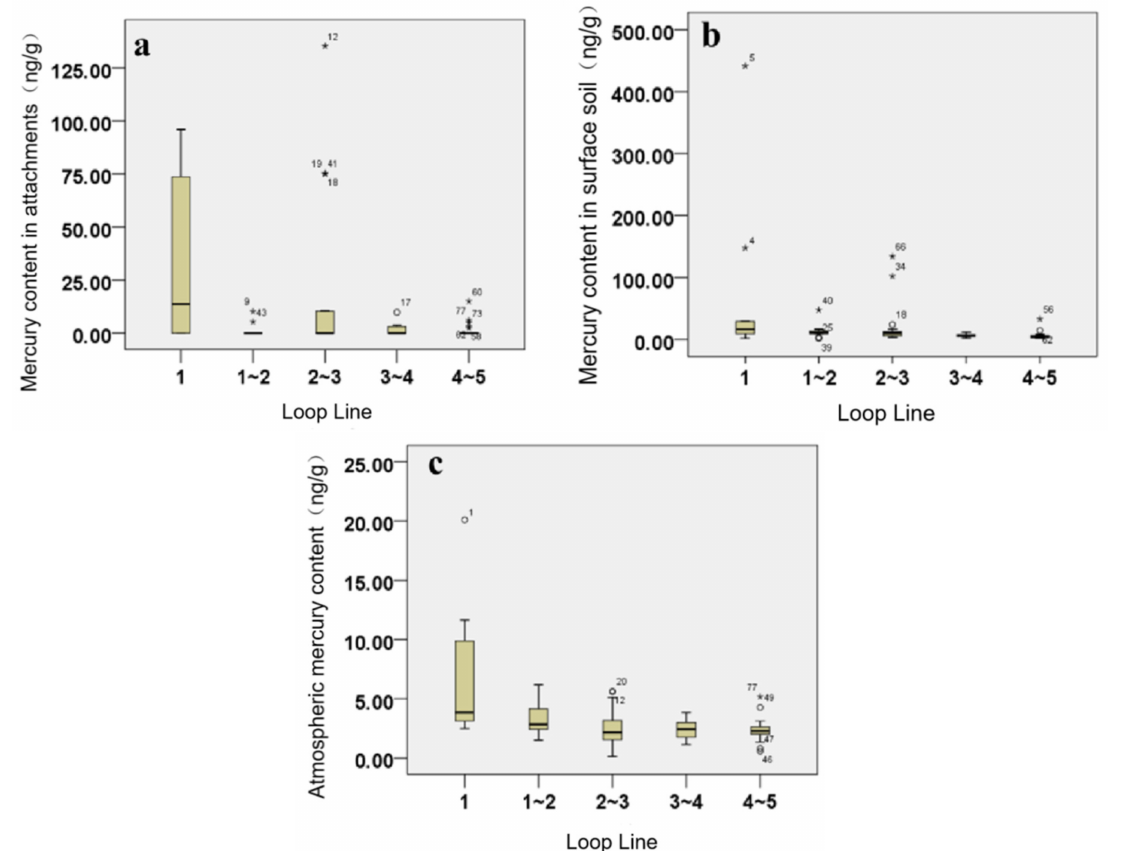
Figure 10. ( a ) Box chart of mercury content levels in the attachments of sample points within the different loop lines of Changchun City. ( b ) Mercury content levels of the surface soil sample points within the different loop lines of Changchun City. ( c ) Mercury content levels of the atmospheric sample points within the different loop lines of Changchun City. “*” means extreme